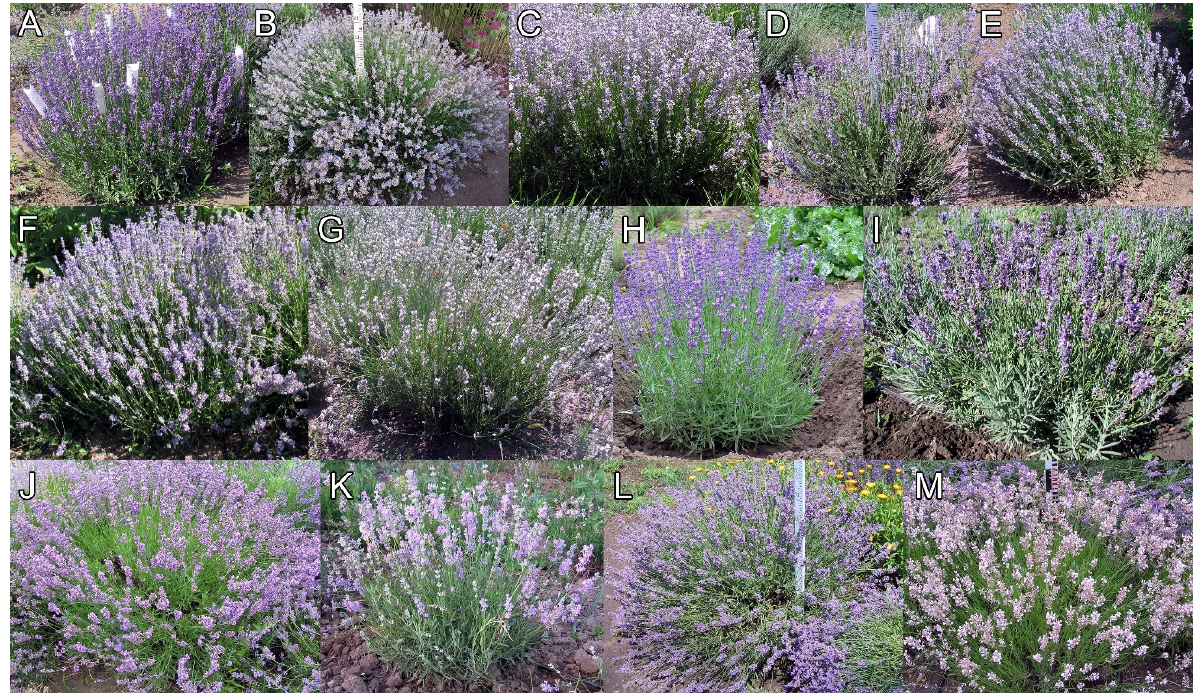
Figure 5. Illustrative photos for the specimens of different studied lavender cultivars: ( A ) 2-15 (1); ( B ) Victoria (2); ( C ) 1-4-09 (3); ( D ) Lidia (4); ( E ) 1-3-16 (5); ( F ) 1-4-09 (6); ( G ) Alba (7); ( H ) 2-1-17 (8); ( I ) 2-2-3 (9); ( J ) 2-4-6 (10); ( K ) 701-2 (11); ( L ) 21-19 (12); ( M ) Rosea (13).